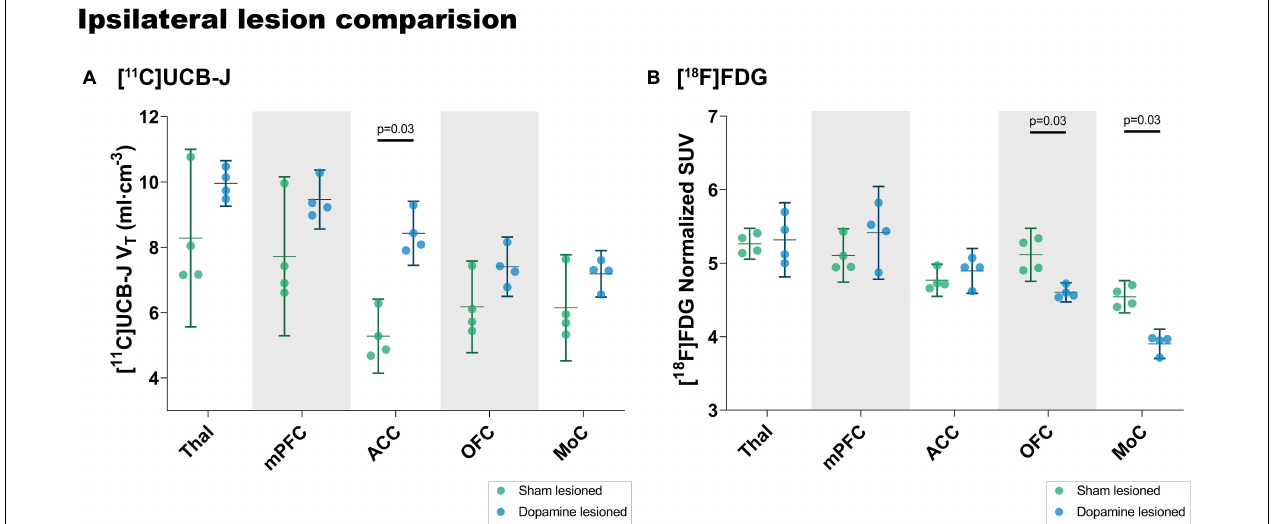
FIGURE 7 | Analysis of [ 11 C]UCB-J V T values (A) and [ 18 F]FDG (B) uptake in the ipsilateral side of dopamine lesioned and sham lesioned animals. Error bar denotes the mean and the 95% confidence interval. Thal = thalamus, mPFC = medial prefrontal cortex, ACC = anterior cingulate cortex, OFC = orbitofrontal cortex, MoC = motor